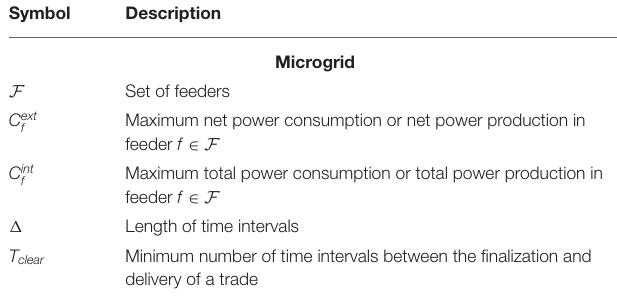
TABLE 1 | List of